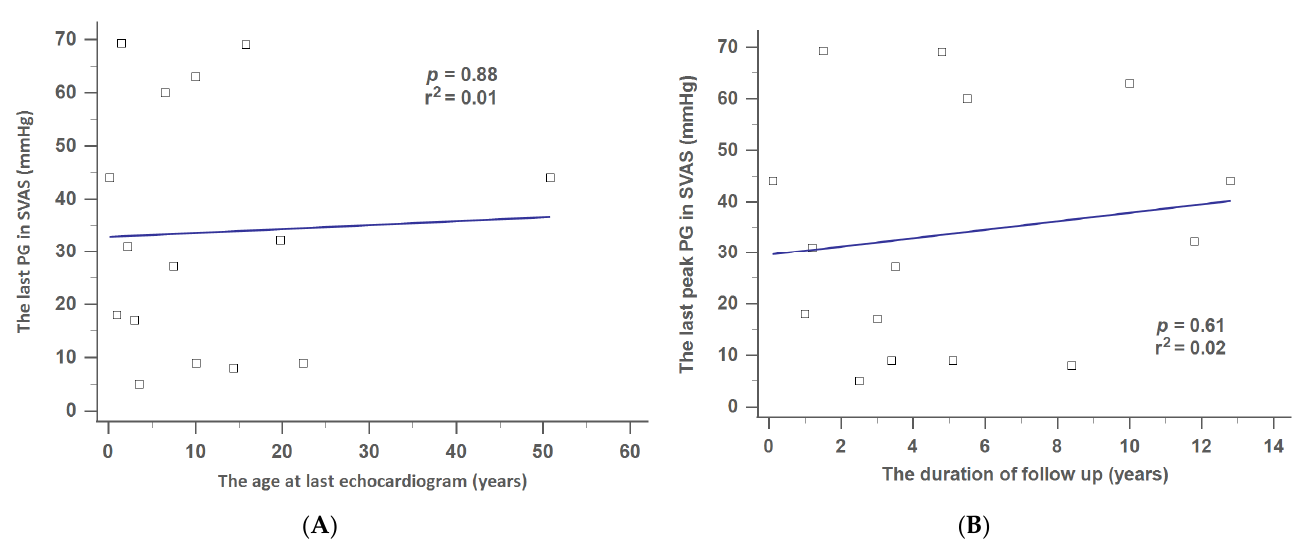
Figure 4. Correlation between the last peak PG and ( A ) age at last echocardiogram, or ( B ) duration of follow-up in SVAS. PG, pressure gradient; SVAS, supravalvular aortic stenosis.